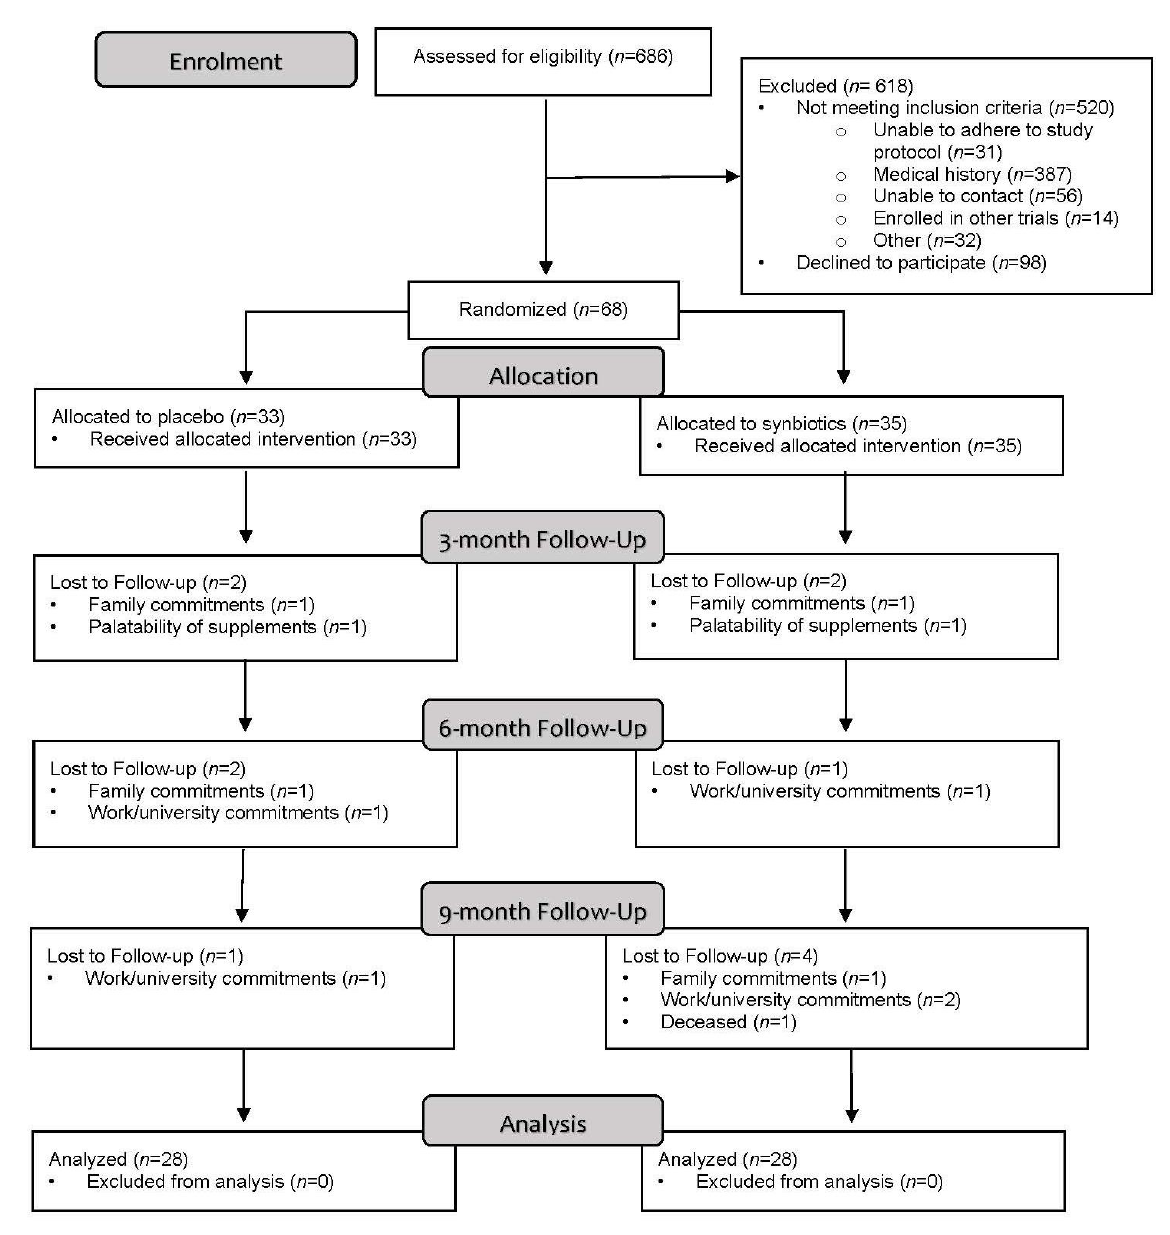
Figure 2. CONSORT flow diagram.